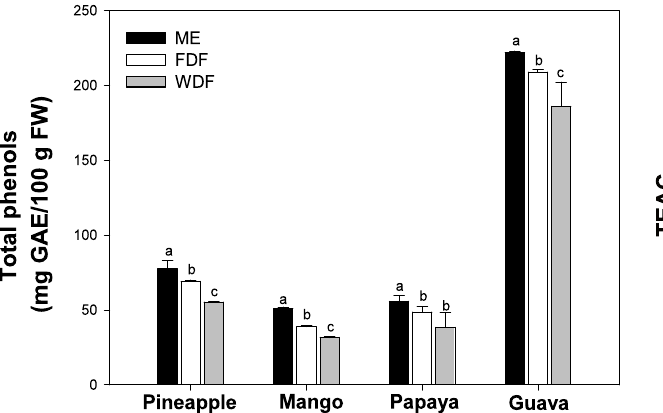
Fig. 1: Total phenols content of methanolic extracts of tropical fruits and reduction by adding fruit dietary fiber (FDF) and wheat dietary fi- ber (WDF). Different letter in bars indicates significant difference (p<0.05) among fiber types by fruit.